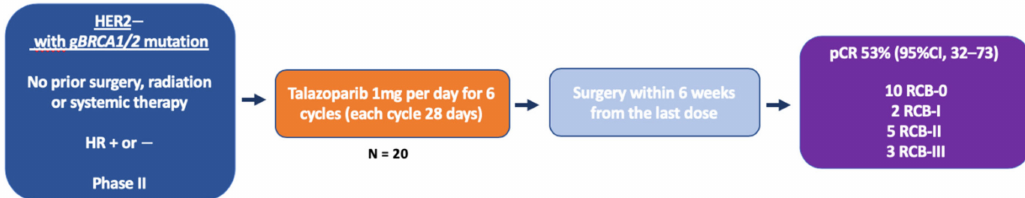
Figure 2. Neoadjuvant Talazoparib for Patients with Operable Breast Cancer With a Germline BRCA Pathogenic Variant. HER2—human epidermal growth factor receptor 2; HR—hormone receptor; pCR—pathological complete response; gBRCA mutation—germline breast cancer 1 or breast cancer 2 mutation; and RCB—residual cancer